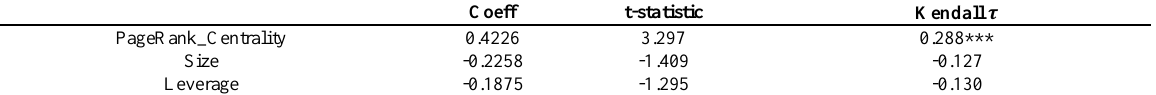
Table 3. Out-of-Sample PageRank centrality on univariate rank regression.